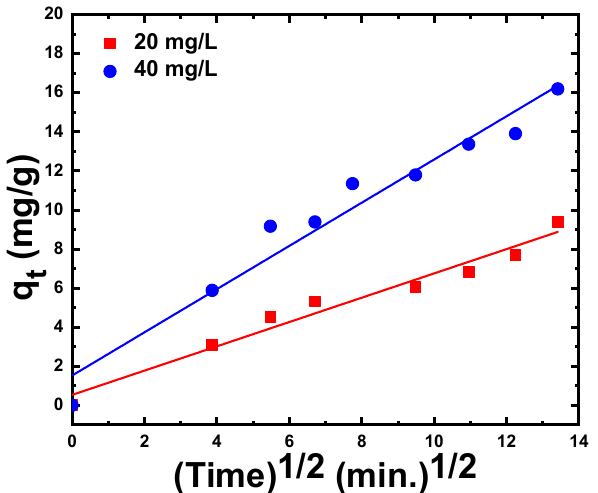
Figure 8. Intra-particle diffusion model ( 𝑞 (cid:3047) versus time ½ ) for CR dye adsorption on ZnS nanoparticles.